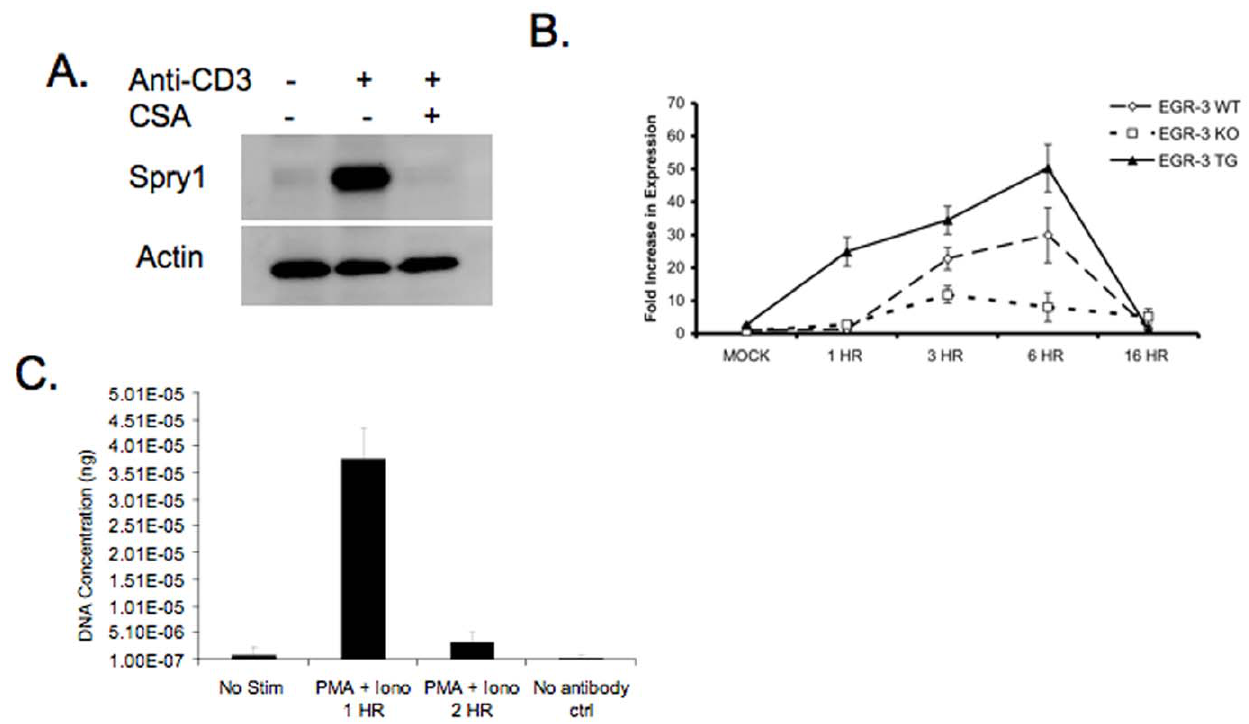
Figure 1. TCR-induced Spry1 is regulated by Egr-3. A. Western blot analysis of Spry1 and actin in previously activated 5C.C7 T cells stimulated with anti-CD3 with or without CSA treatment. B. Real-Time PCR analysis of Spry1 expression in wild type, Egr-3 2 / 2 and Egr-3 overexpressing CD4 + T cells stimulated with anti-CD3 and anti-CD28. (N=3). Mock treated cells were stimulated with anti-CD28 alone. C. CHiP analysis of Egr-3 binding to the Sprouty-1 promoter following PMA and Ionomycin stimulation. Error bars represent one standard deviation of the mean. All experiments were performed at least three times.